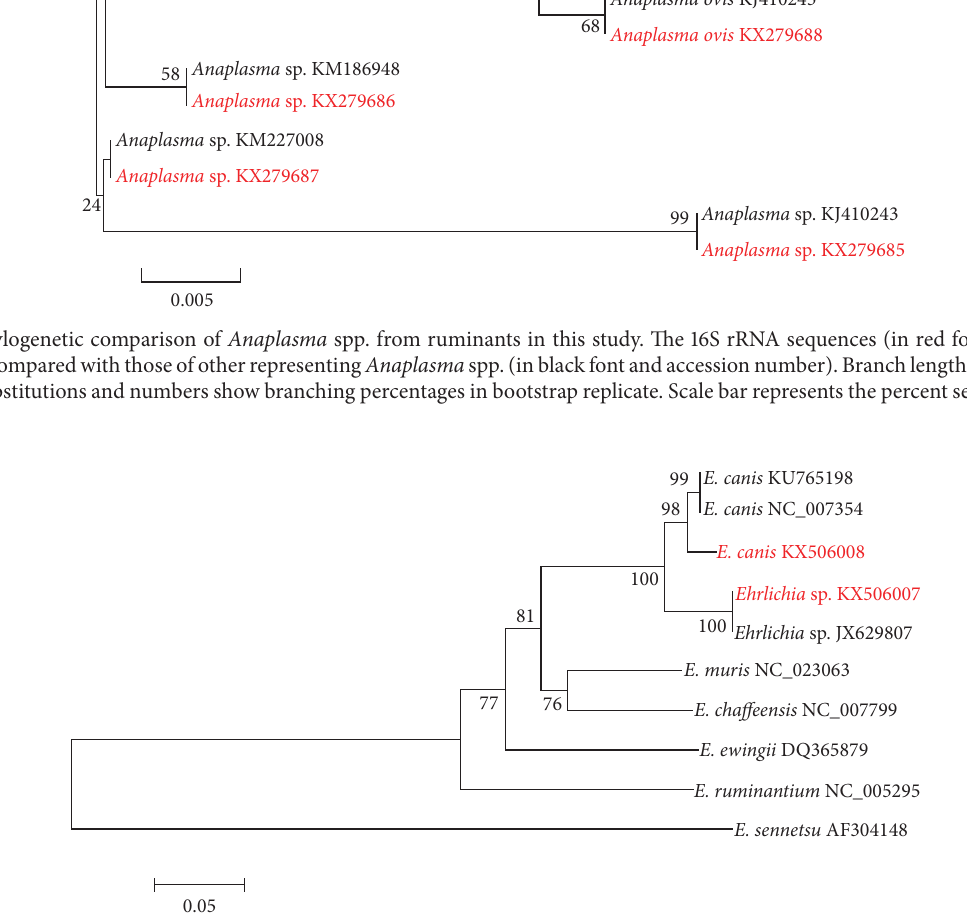
Figure 4: Phylogenetic comparison of Ehrlichia spp. from ruminants in this study. The gltA sequences (in red font and accession number) are compared with those of other representing Ehrlichia spp. (in black font and accession number). Branch lengths are measured in nucleotide substitutions and numbers show branching percentages in bootstrap replicate. Scale bar represents the percent sequence